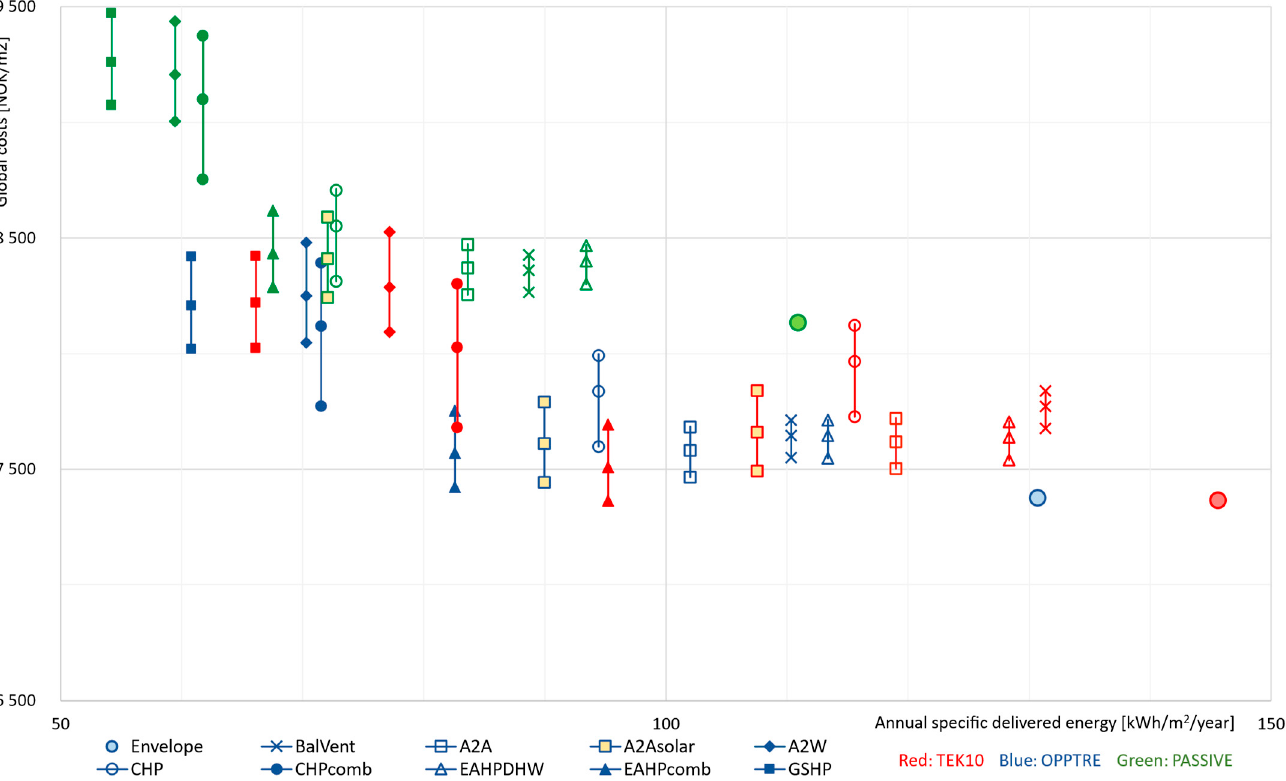
Figure 8. Specific global costs and delivered energy of the Malvik house.